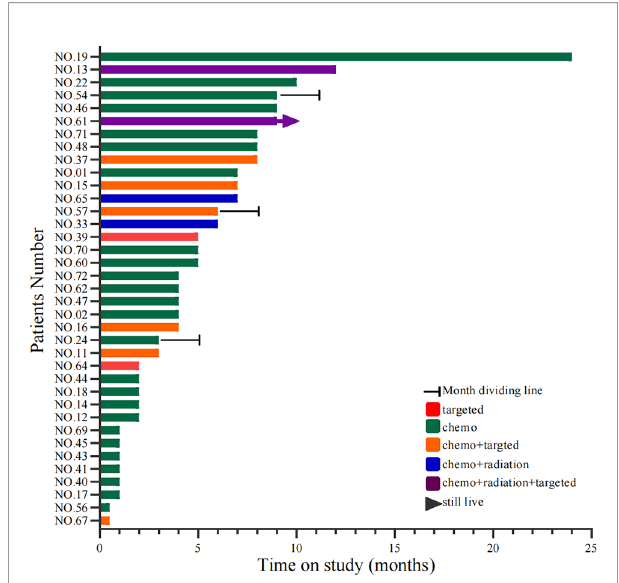
FIGURE 7 | Swimming lane diagram of PFS in fi rst-line treatment after SCLC transformation. PFS, Progression-free survival; SCLC, Small cell lung cancer. Target type: No. 39, osimertinib; No. 64, afatinib; No. 11/15/37/67, erlotinib; No. 16, osimertinib; No. 57, ge fi